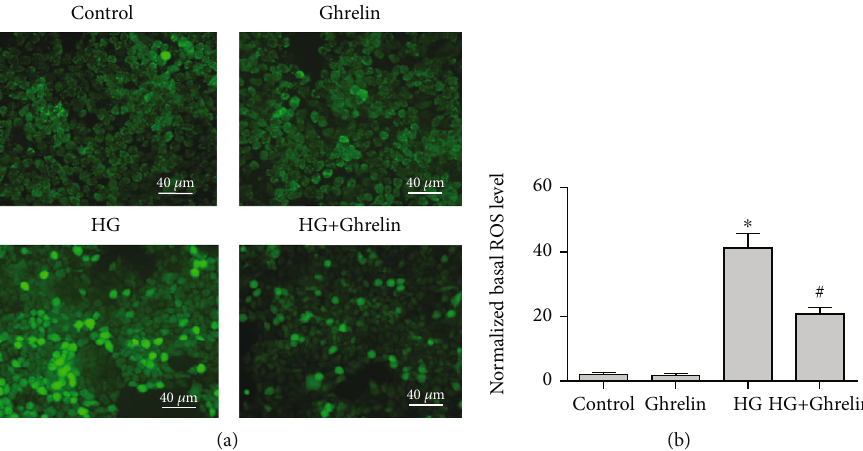
Figure 2: Ghrelin inhibited HG-induced HLE cell oxidative stress. (a) E ff ect of ghrelin on basal ROS level in HLE cells measured by DCFDA fl uorescent probe. (b) Quantitative analyses of intracellular ROS generation in HLE cells. ∗ P < 0 : 05 vs. control group; H 2 # P < 0 : 05 vs. HG group.